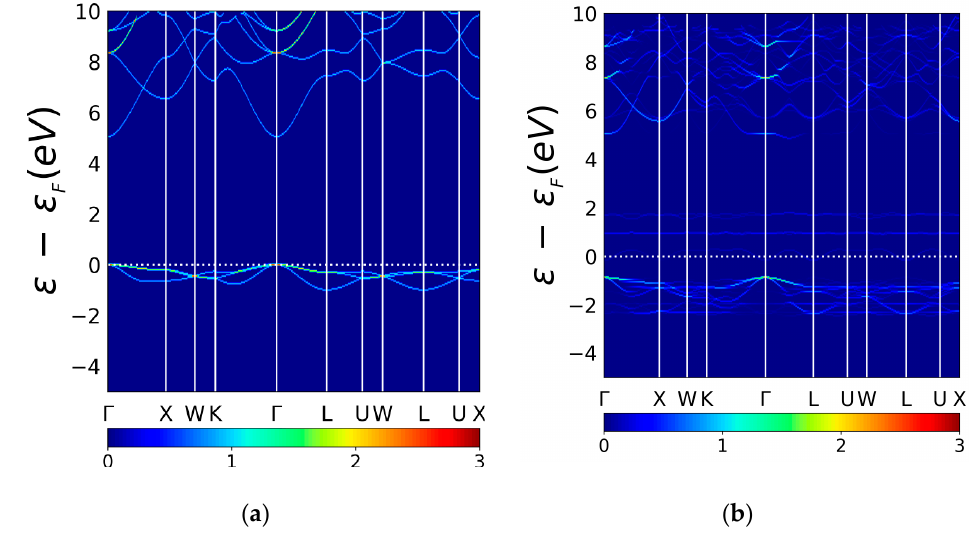
Figure 7. E ff ective band structure (EBS) for pristine SC K 8 Cl 8 ( a ) and EBS for doped SC K 7 Cl 8 :Cu ( b ), along with the same high-symmetry directions in the BZ and the same energy range. The color scale represents the number of PC bands crossing the energy interval (0.05 eV) at a given primitive wave vector [41,51,76].